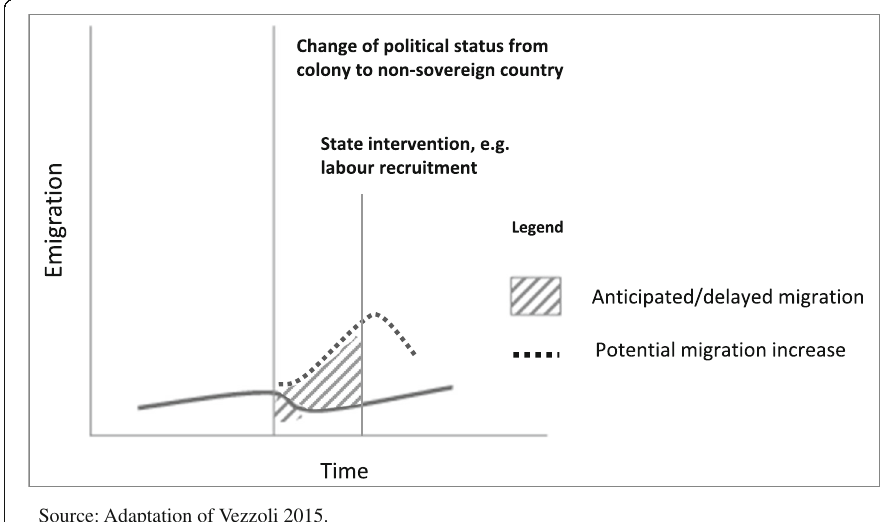
Fig. 9 How political status change from colony to non-sovereignty possibly affects internal and international